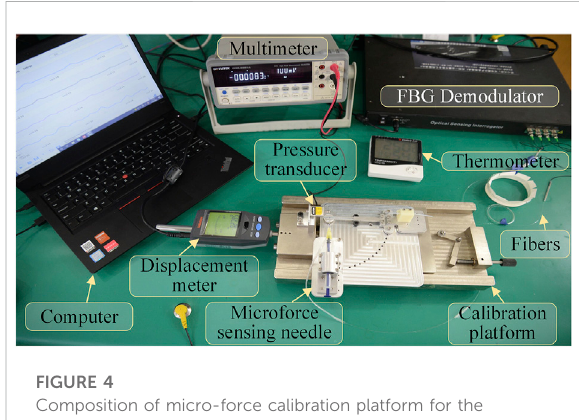
FIGURE 4 Composition of micro-force calibration platform for the injection